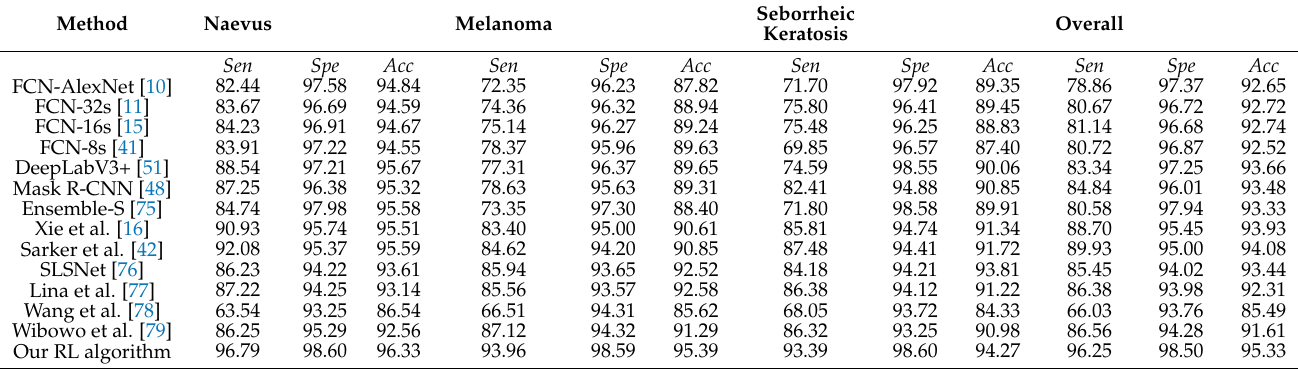
Table 5. For the ISIC 2017 skin lesion segmentation test set, we evaluated the performance of our proposed RL method and the state-of-the-art segmentation method. The statistical measures used are Sen , Spe , Acc , and the melanoma category is seborrheic keratosis